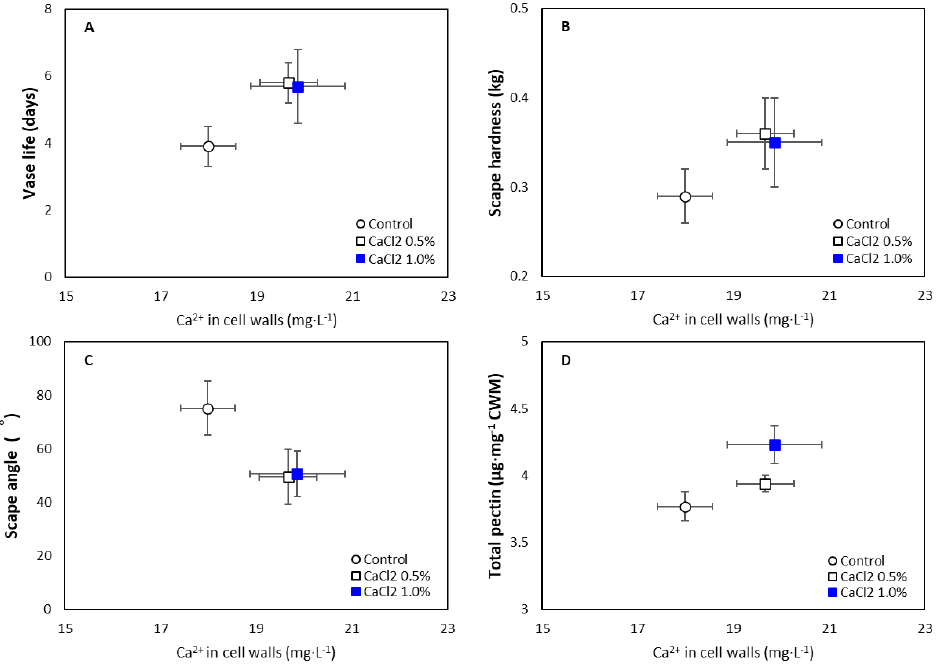
Figure 2. Effects of calcium application on Ca 2+ levels in the cell walls and their relationship to the vase life and scape quality and pectin durability of gerbera ‘Harmony’ cut flowers. ( A ) Vase life; ( B ) scape hardness; ( C ) scape angle; ( D ) total pectin. Vertical and horizontal bars represent standard errors ( n = 30 for vase life and 10 for the rest).